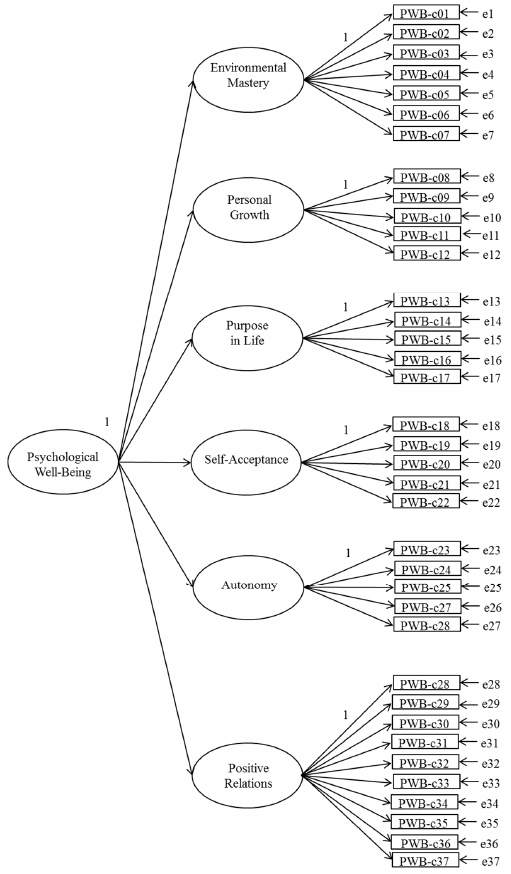
Figure A1. Theoretical second-order factor model of the Psychological Well-Being scale for children. Ovals represent latent variables and rectangles manifest variables.